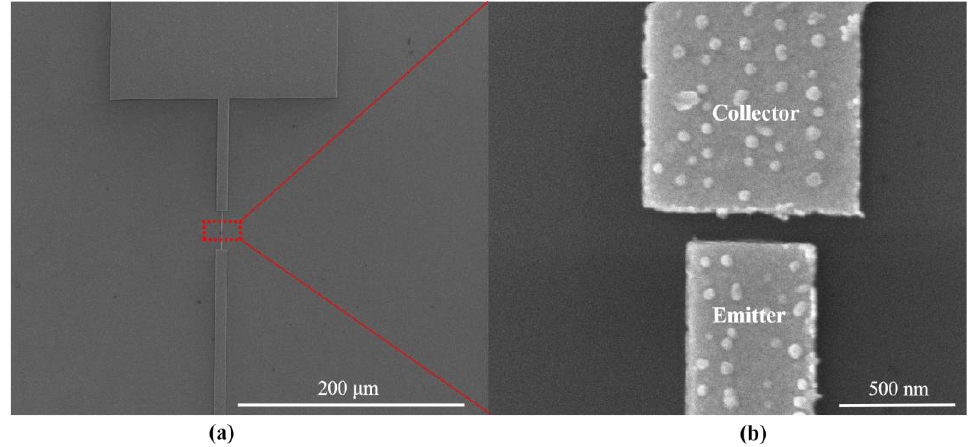
Figure 4. SEM images of ( a ) fabricated planar-type NVCT, and ( b ) the zoom-in of the nanoscale vacuum channel structure.